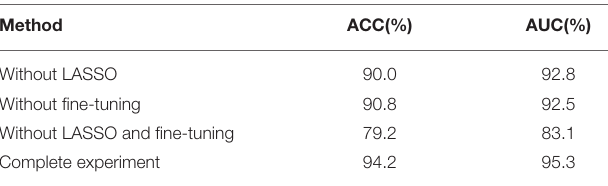
TABLE 4 | Classification performance comparison with different experiment setups, where without LASSO and without fine-tuning , representing transfer learning technique and LASSO algorithm, respectively, were not performed in the